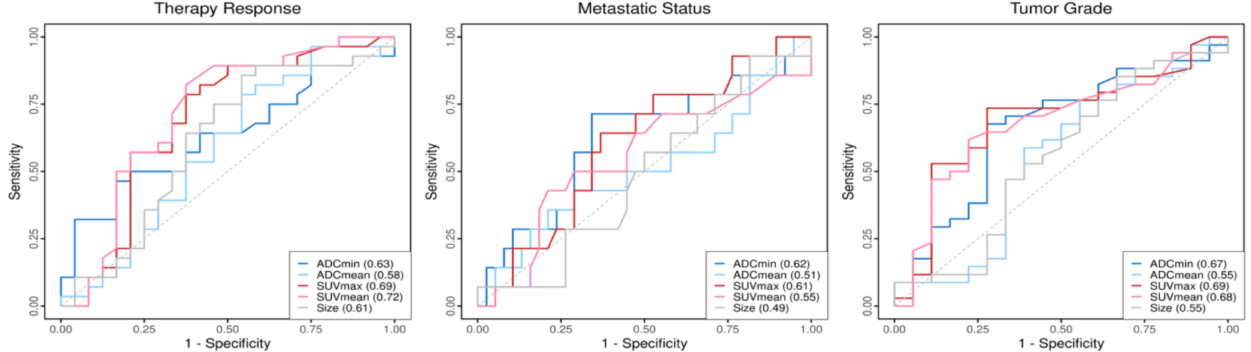
Figure 3. ROCs of the quantitative imaging parameters in dependence of the different outcome variables. Corresponding AUC values of the parameters are shown within the